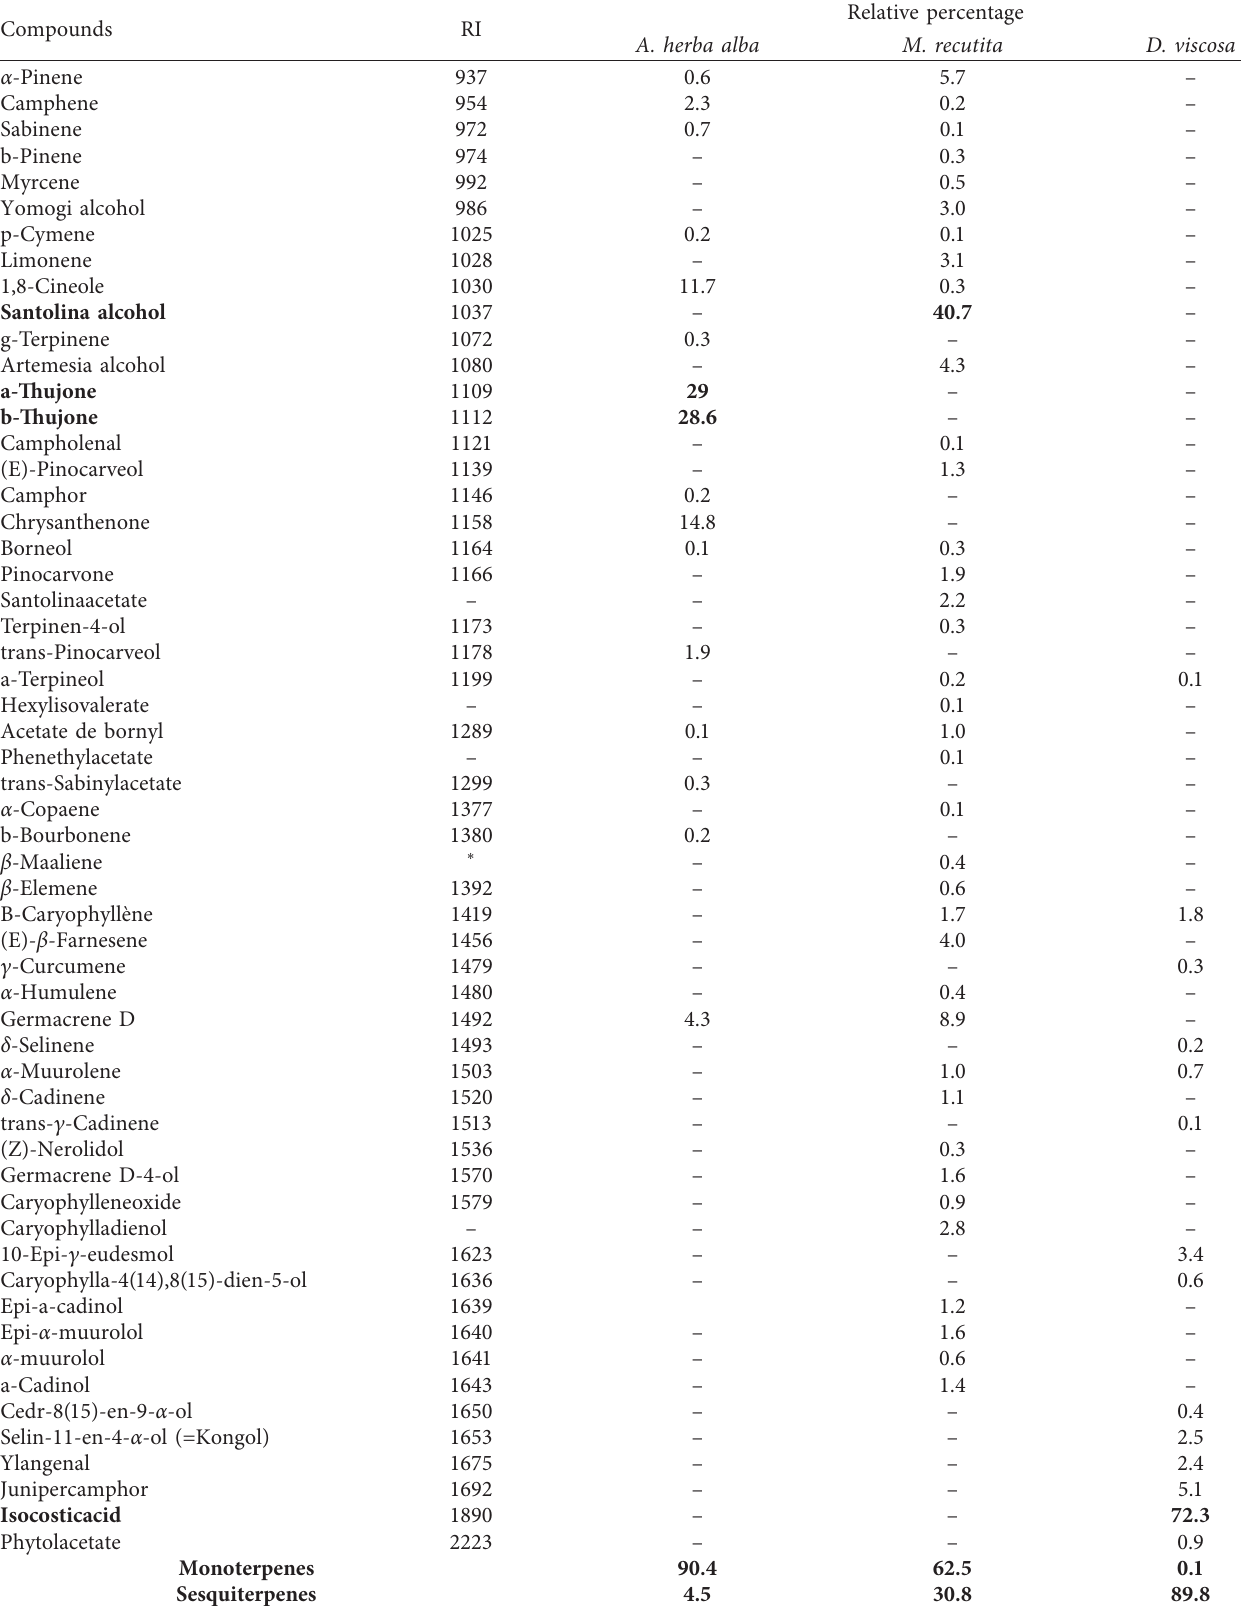
Table 2: Chemical composition of essential oils from Artemisia herba alba Asso., Matricaria recutita L., and Dittrichia viscosa L. Compounds